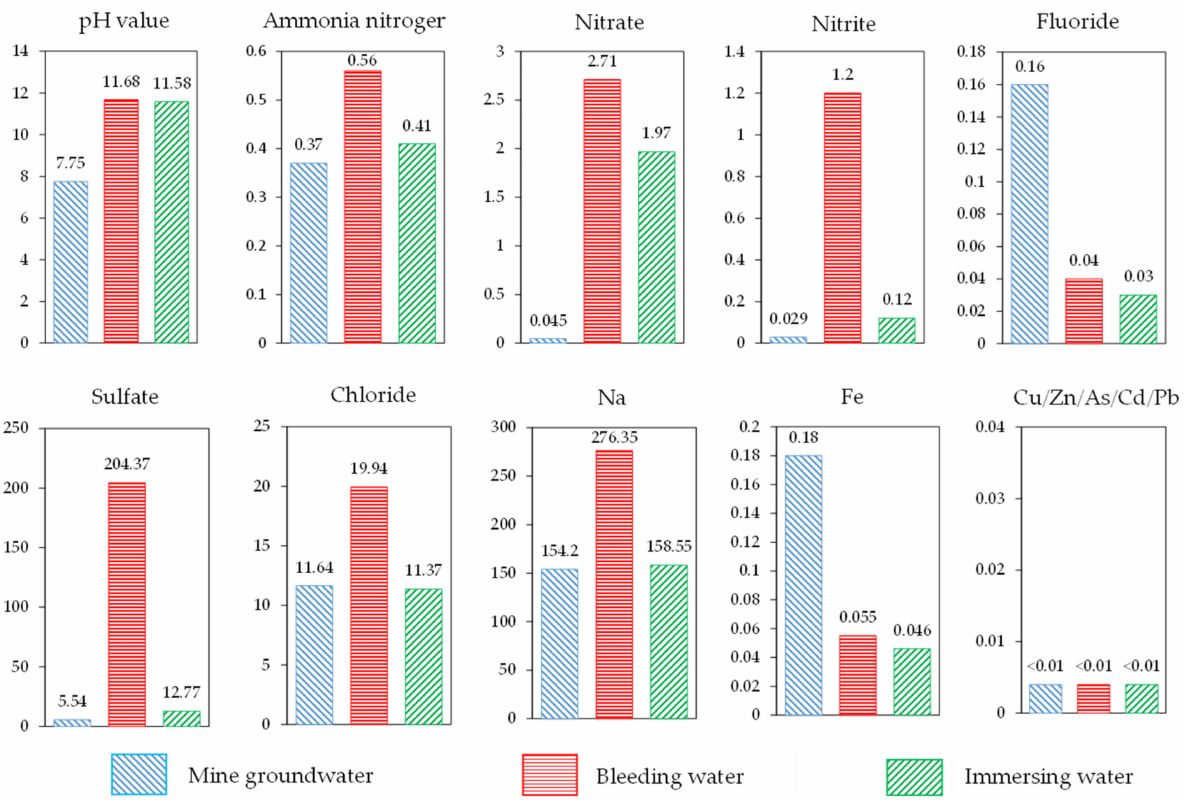
Figure 4. The pollutants composition of mine groundwater, bleeding water, and immersing